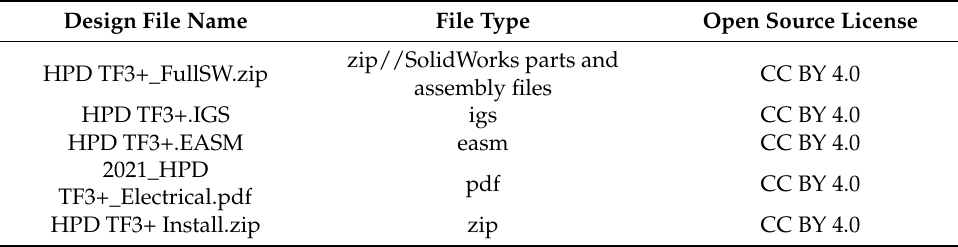
Table A1. Design files.